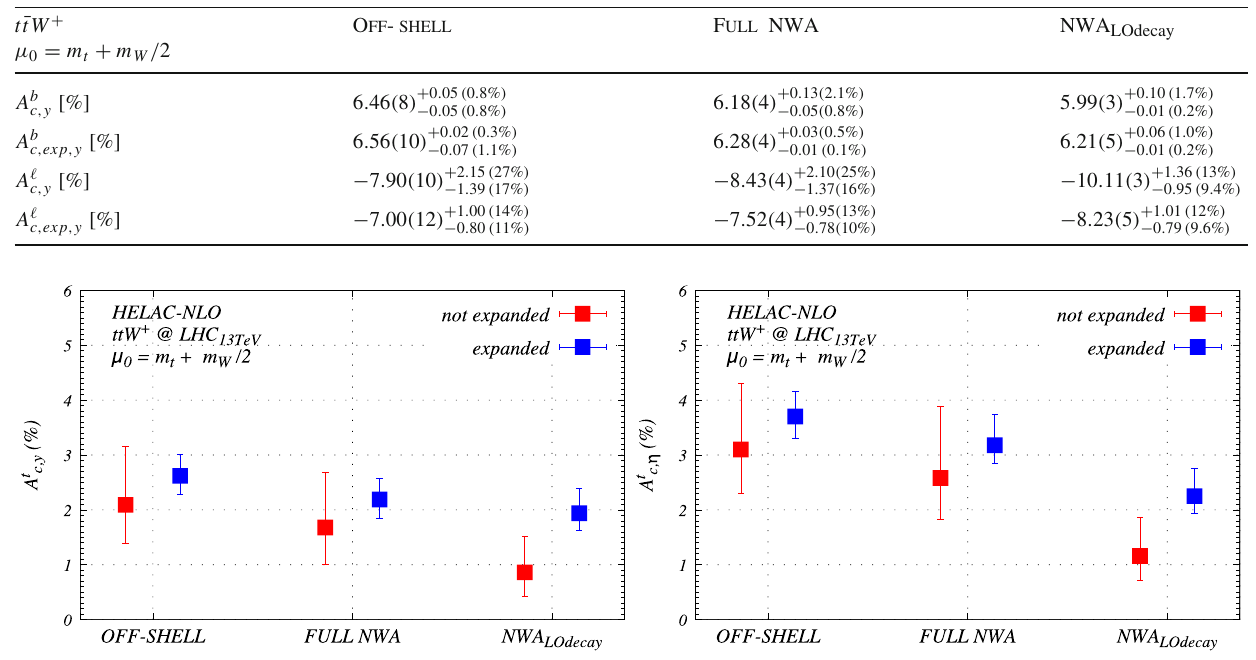
Fig. 5 Unexpanded and expanded A t c asymmetry at NLO in QCD for pp → t ¯ tW + in the multi-lepton channel at the LHC with TeV. Various approaches for the modelling of the top quark produc-